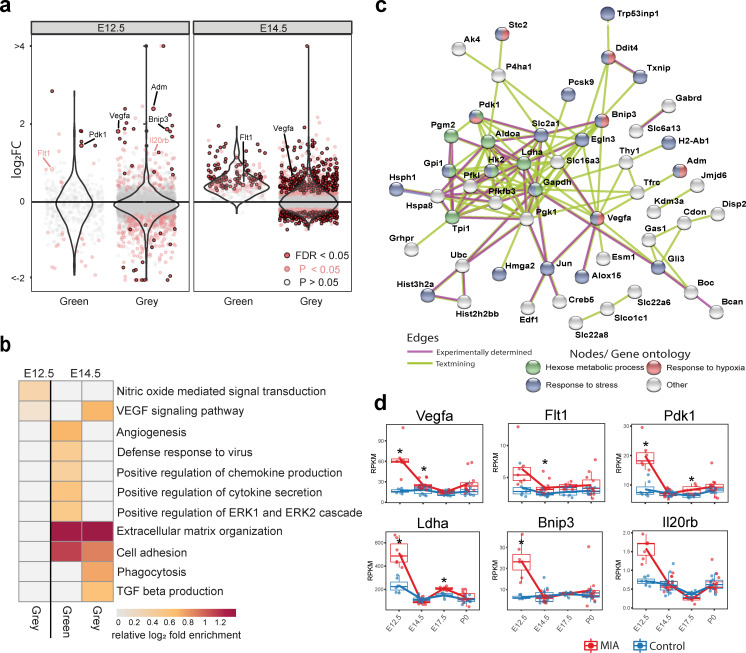
Green and Grey co-expression modules capture acute transcriptional response at 6 hr and 2 days following MIA exposure.(a) Violin plots visualize distribution of log2 fold changes of Green and Grey module gene expression between control and MIA animals. At E12.5, an initial set of genes in the Green and Grey modules are induced and DE in MIA samples. By E14.5, generalized module expression exhibits induction in the MIA samples, with particularly strong change for the Green module, where nearly all genes are upregulated. Genes with expression trajectories shown in (d) are labeled. (b) Gene set enrichment analysis of GO BP terms significantly enriched among DE genes (FDR < 0.05) at E12.5 and E14.5 in Green and Grey modules showing upregulation of angiogenesis and immune pathways. Representative enriched GO BP terms with p < 0.05 colored by enrichment; gray represents enrichment p > 0.05 (Fisher’s exact test). (c) STRING protein–protein interaction network of E12.5 DE genes (FDR < 0.05) colored by annotation to GO BP terms. There were significantly more interactions than expected by chance among these genes. (d) RPKM expression plots of genes that are associated with this network show acute DE at E12.5. Stars represent FDR < 0.05.